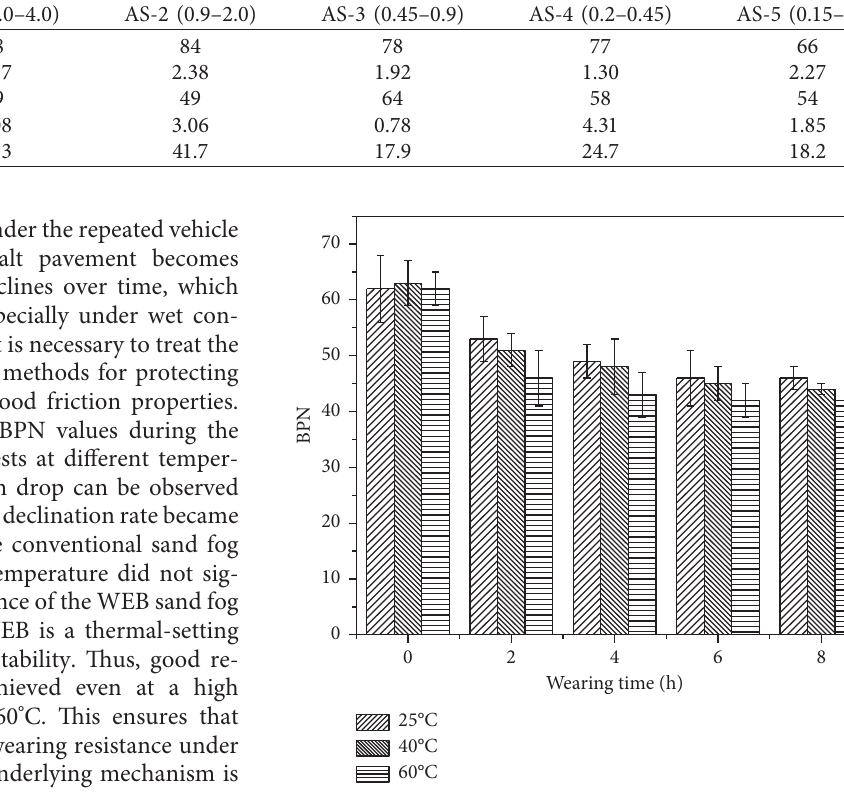
Figure 5: Skid resistance of WEB sand fog seal after different wearing periods at different